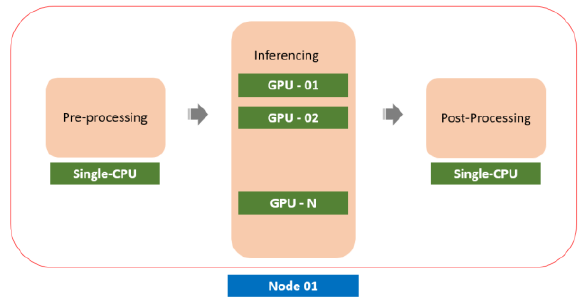
Figure 7. A semantic diagram of single-CPU multi-GPU MAPLE workflow model using a single HPC node.